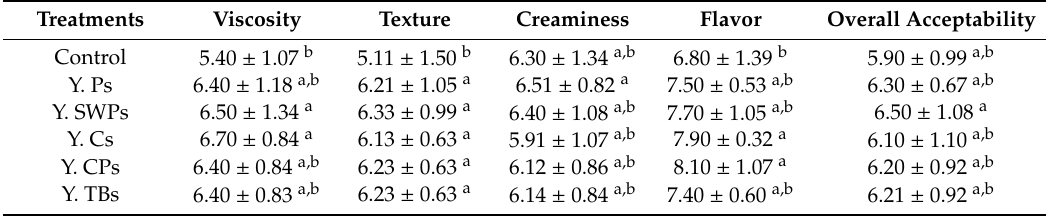
Table 3. Effect of starches on the sensory evaluation of yogurt. Table 3. E ff ect of starches on the sensory evaluation of